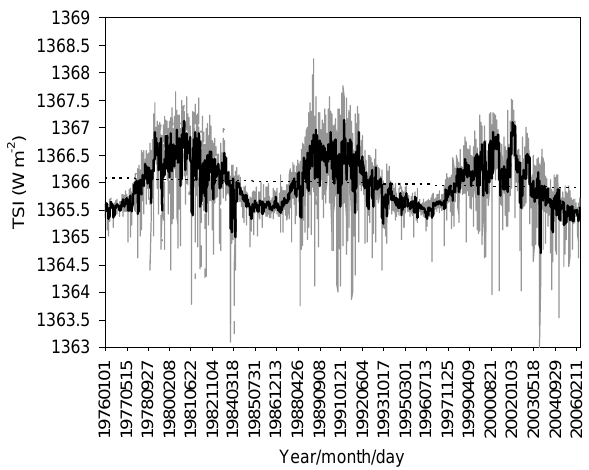
13631363.513641364.513651365.513661366.513671367.513681368.51369 Fig. 1. The variation of total solar irradiance (TSI) during 1976– Fig. 1. The variation of total solar irradiance (TSI) during 1976-2006. The solar constant obtained is 2006. The solar constant obtained is 1366.1Wm − 2 . Data are from 1366.1 Wm -2 . Data are from the HF on Nimbus 7, the ACRIM I on SMM, the ERBE on ERBS, the the HF on Nimbus 7, the ACRIM I on SMM, the ERBE on ERBS, ACRIM II on UARS, the VIRGO on SOHO, and the ACRIM III on ACRIM-Sat (see Table 2). the ACRIM II on UARS, the VIRGO on SOHO, and the ACRIM III on ACRIM-Sat (see Table